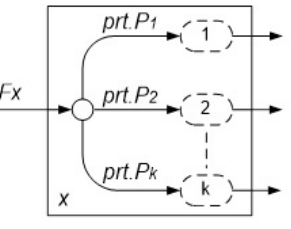
Figure 5. Generalized representation of the functioning of a virtual